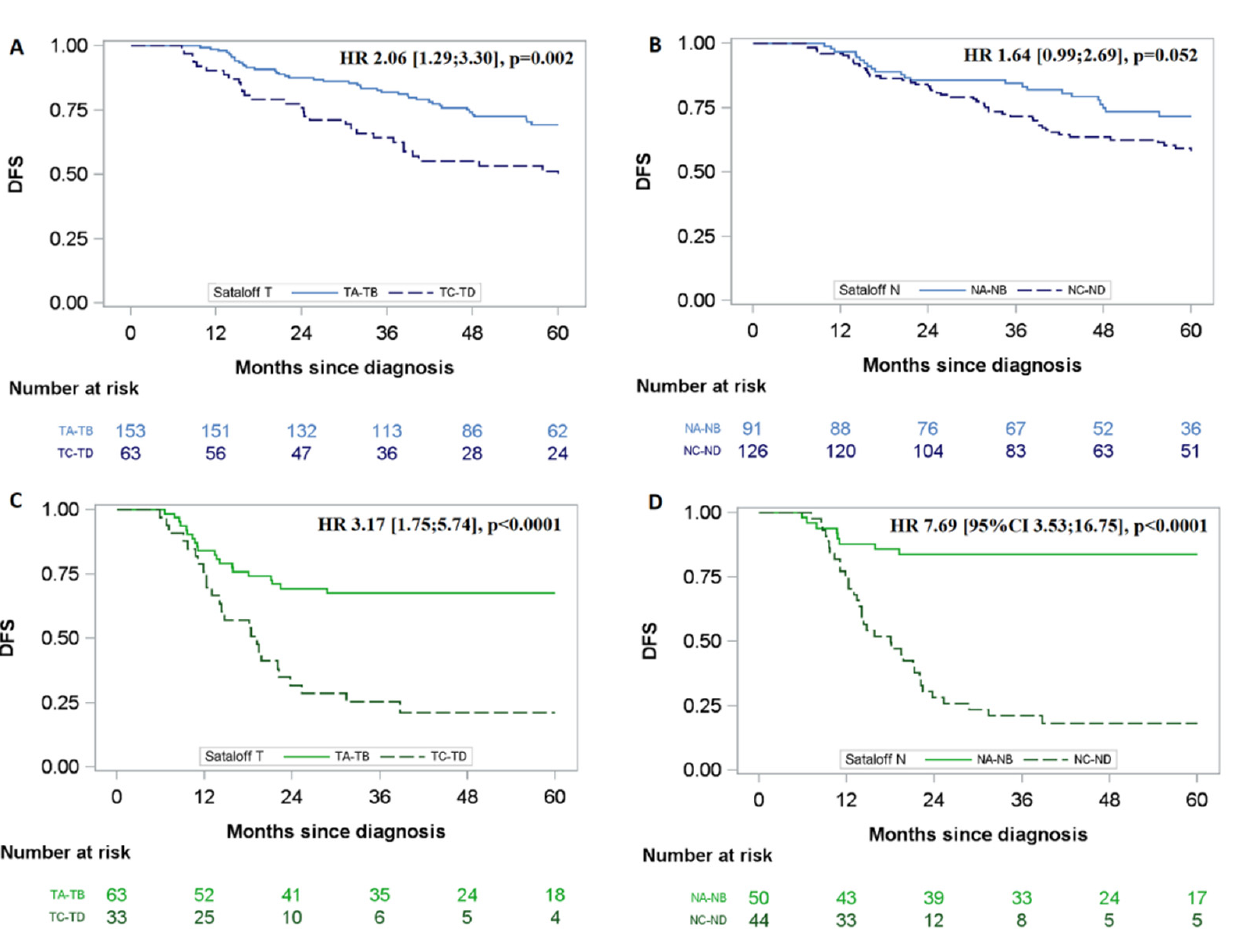
Table 4. Multivariate analyses of prognostic factors for disease-free survival (DFS) stratified by tri- ple-negative status.